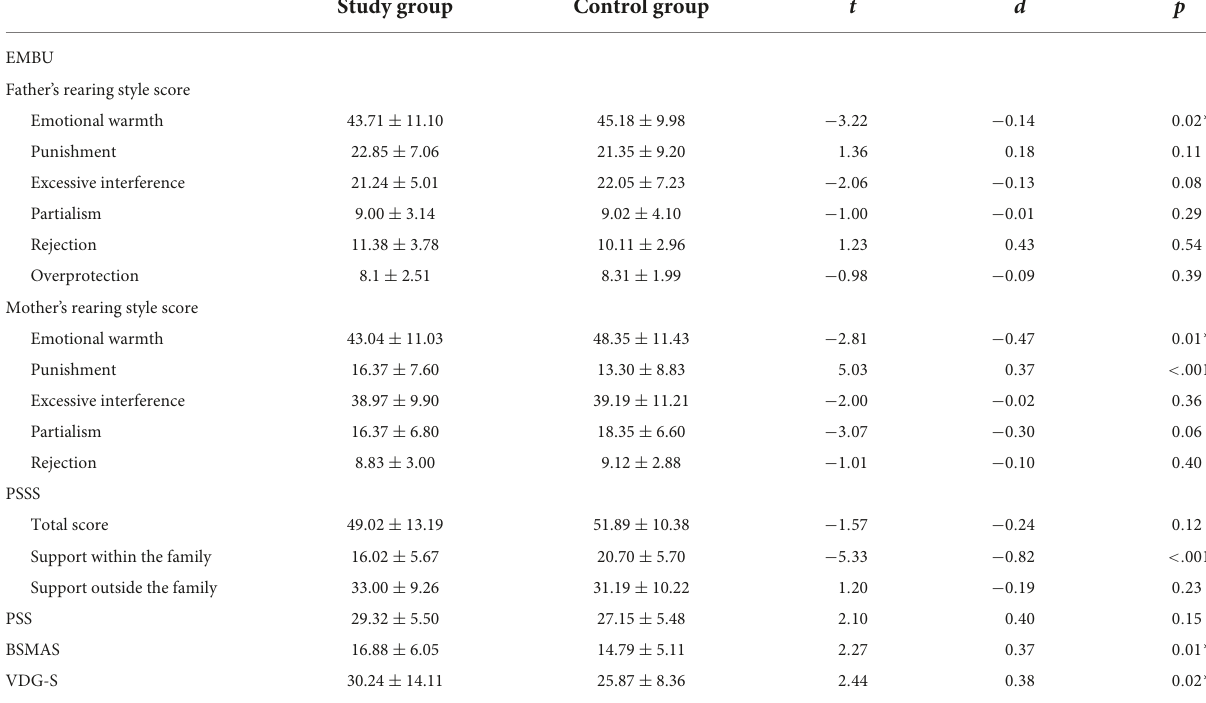
TABLE 2 Differences between the study group and the control group in EMBU, PSSS, PSS, BSMAS, and